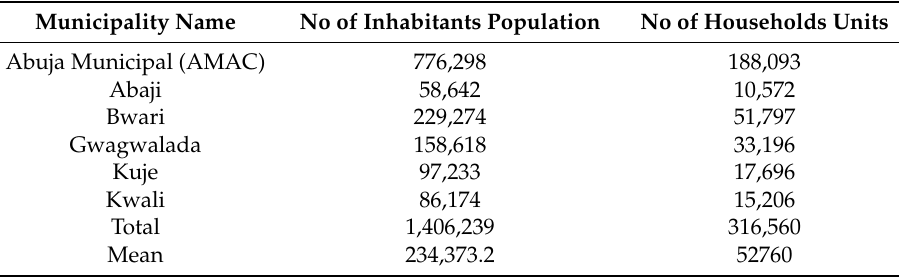
Table 1. Population statistics of the municipalities in FCT for the year